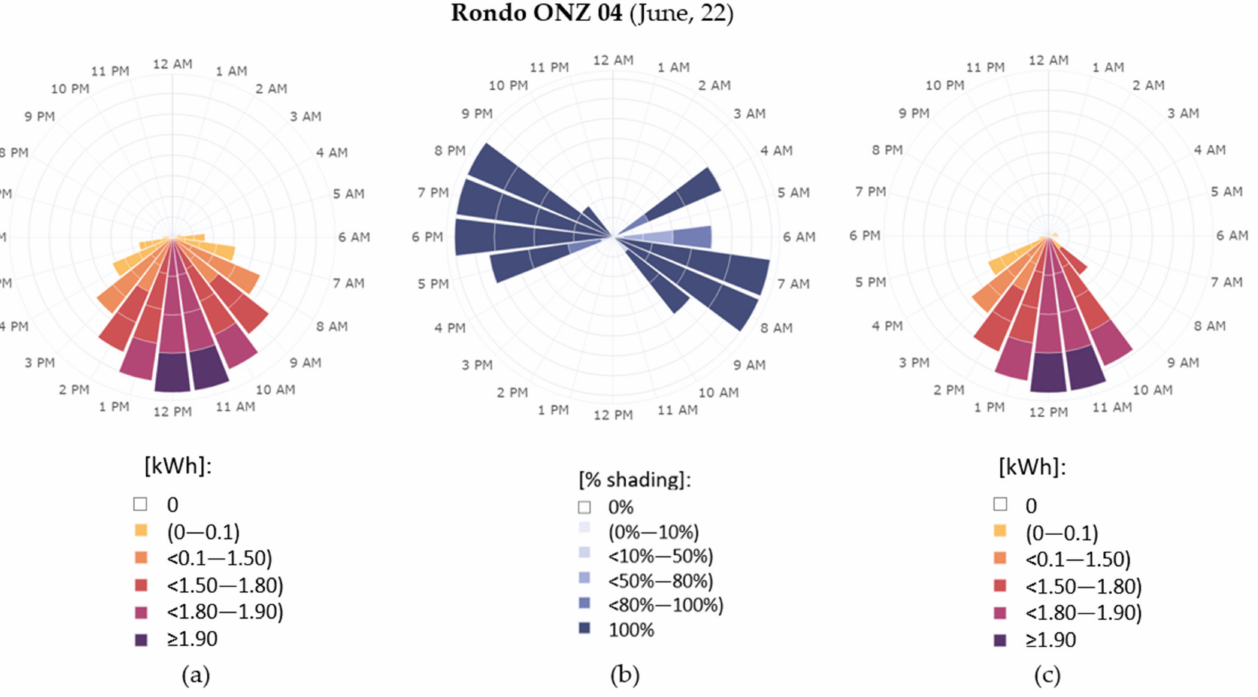
Figure 25. Results obtained for the shelter roof in the neighbourhood of Rondo ONZ 04 tram stop for 22 June 2020: ( a ) solar potential in kWh per stop shelter roof area; ( b ) percentage loss due to shelter shading; ( c ) actual solar potential including shading (kWh) per stop shelter roof area. The maximum value is about 1.9 kWh (6.84